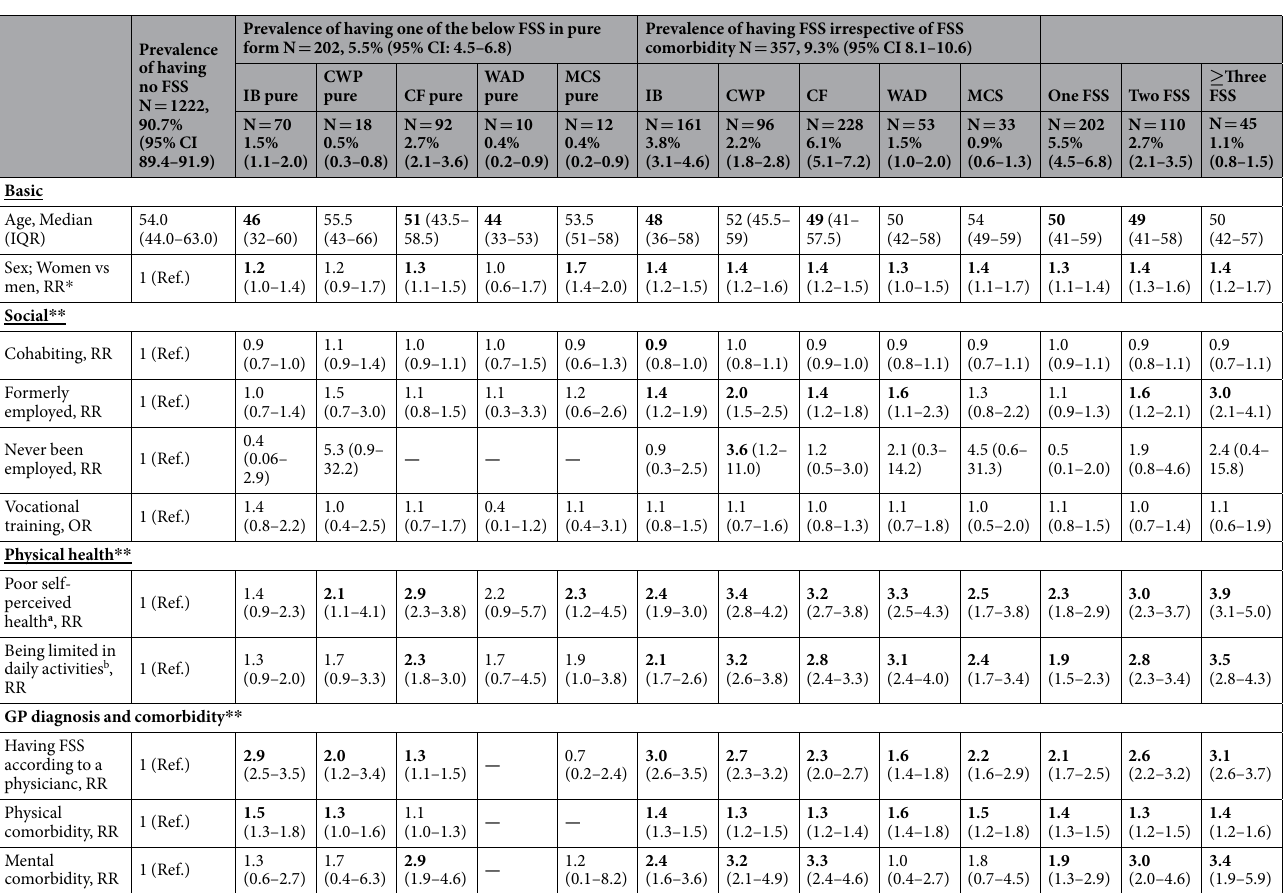
Table 1. Prevalence and characteristics of participants with functional somatic syndromes. Abbreviations: FSS = functional somatic syndrome; IB = irritable bowel; CWP = chronic widespread pain; CF = chronic